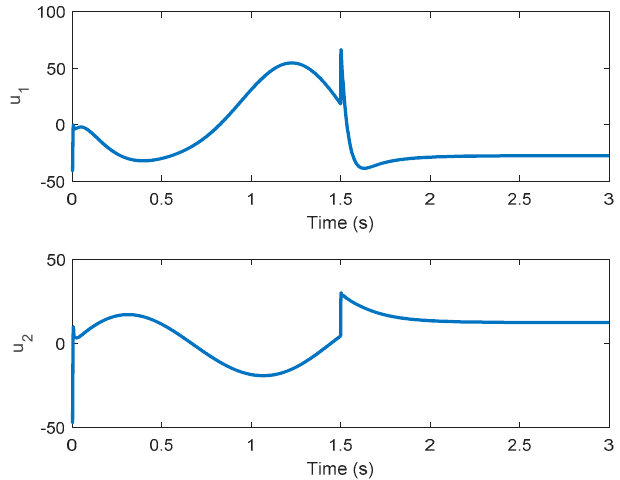
Figure 4. Control inputs based on the fixed PID controller and unknown perturbation.